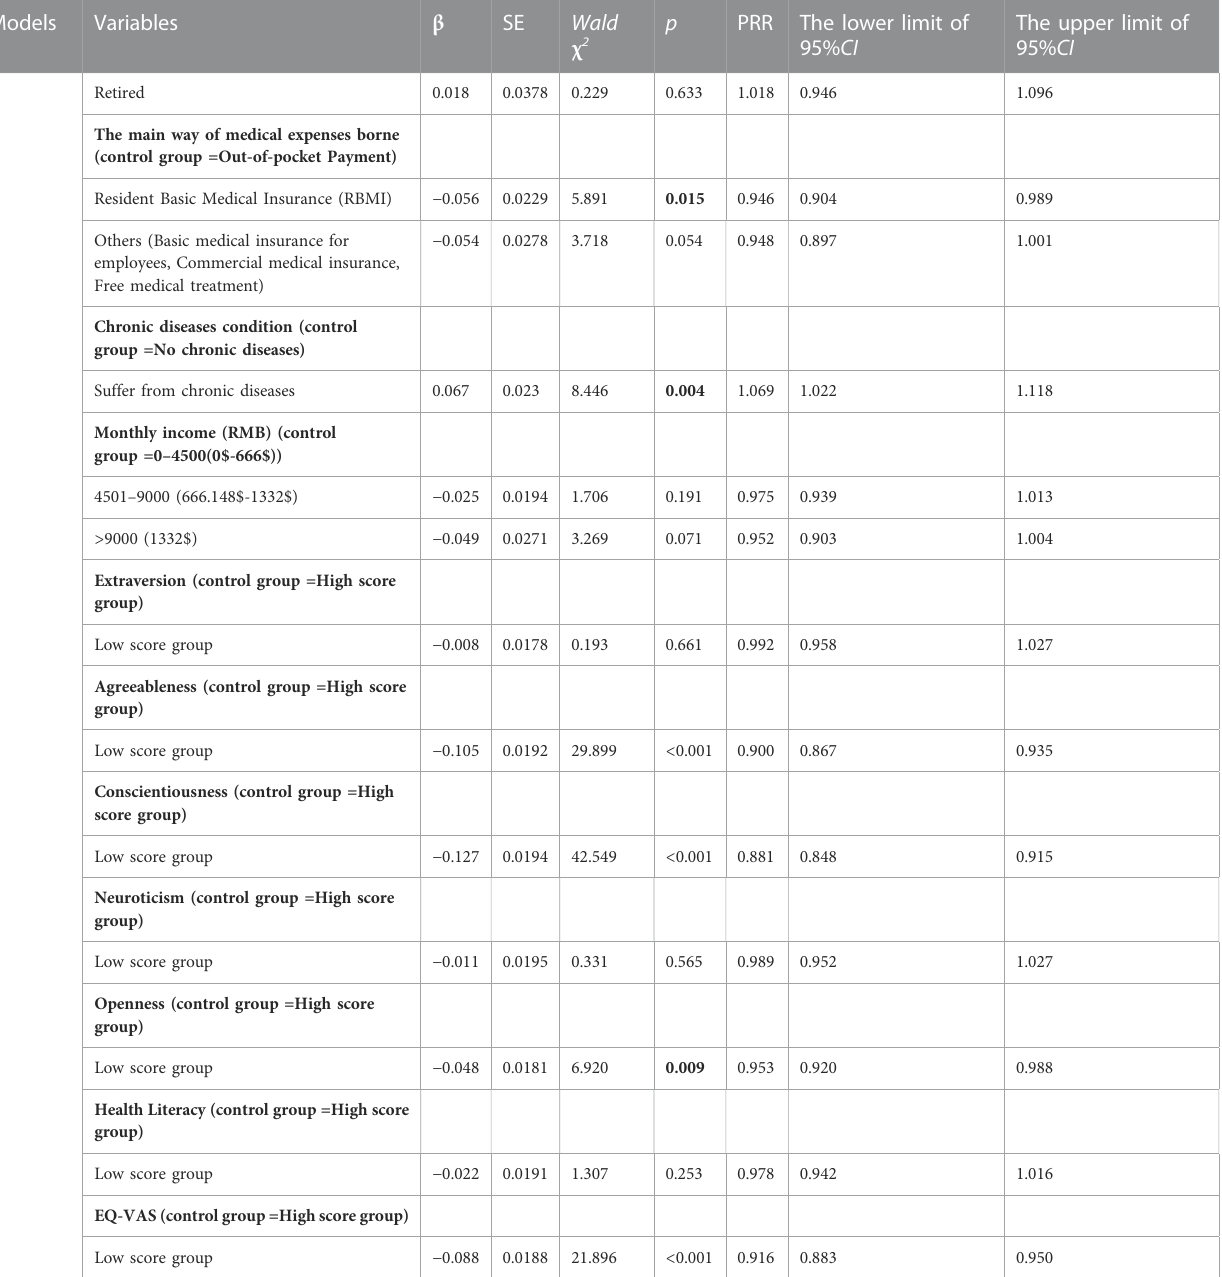
TABLE 4 ( Continued ) Multilevel log-binomial regression results with drug ef fi cacy as the dependent variable.